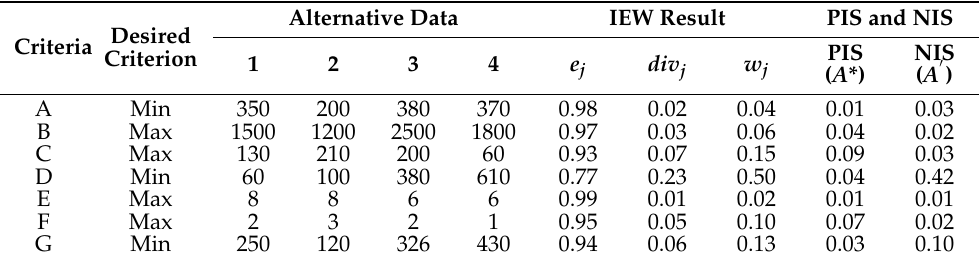
Table 4. Alternative and criteria analysis from IEW and TOPSIS.